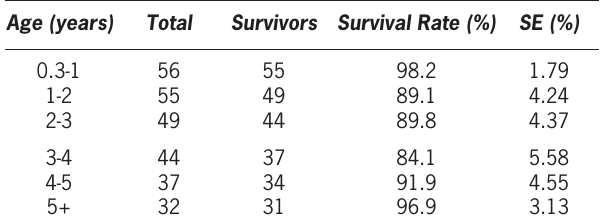
Table 2. Age-specific annual survival rates for Ray Mountain and Hodzana Hills female